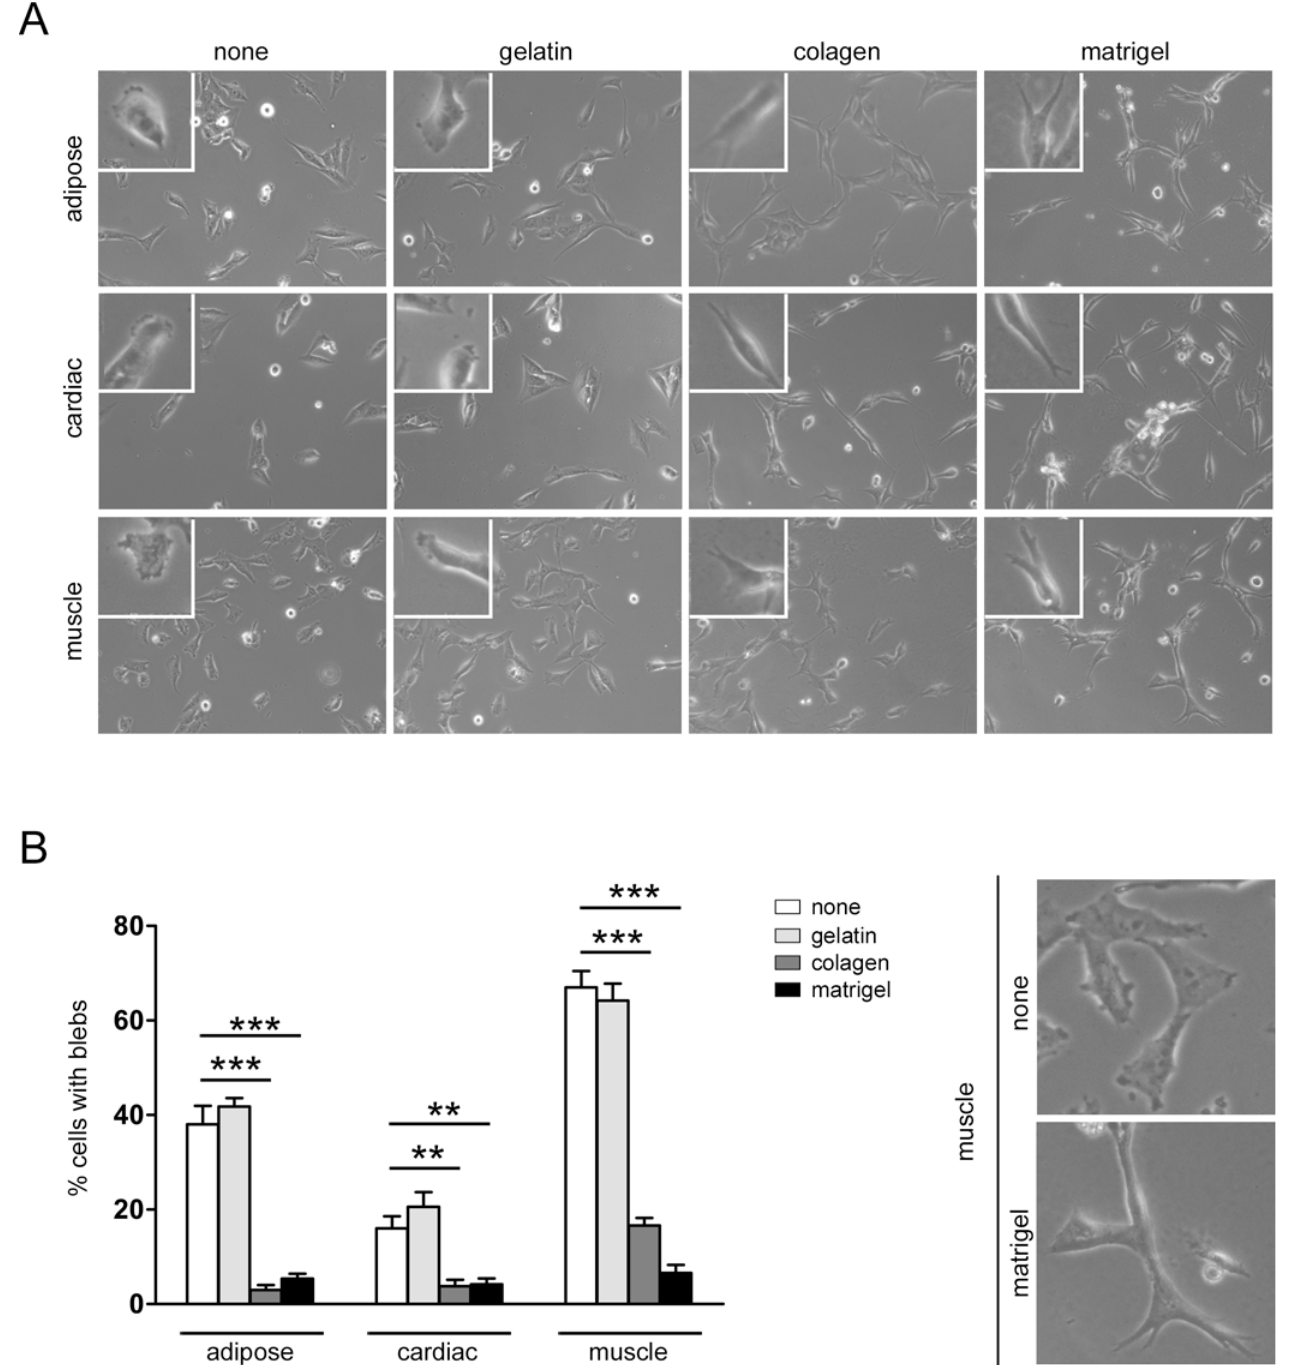
Fig 3. Mesenchymal precursors cultured on different matrices. (A) Representative phase contrast images (10x) of MPs without matrix, on gelatin, collagen and Matrigel. Higher magnifications of selected cells are shown in the upper left corner. (B) Quantification of the percentage of cells with blebs and a comparison of muscle precursor images. Blebbing can be observed in control (no matrix) conditions.; Statistical analysis were performed using One-way ANOVA, Bonferroni; ** P < 0.01; *** P < 0.001.